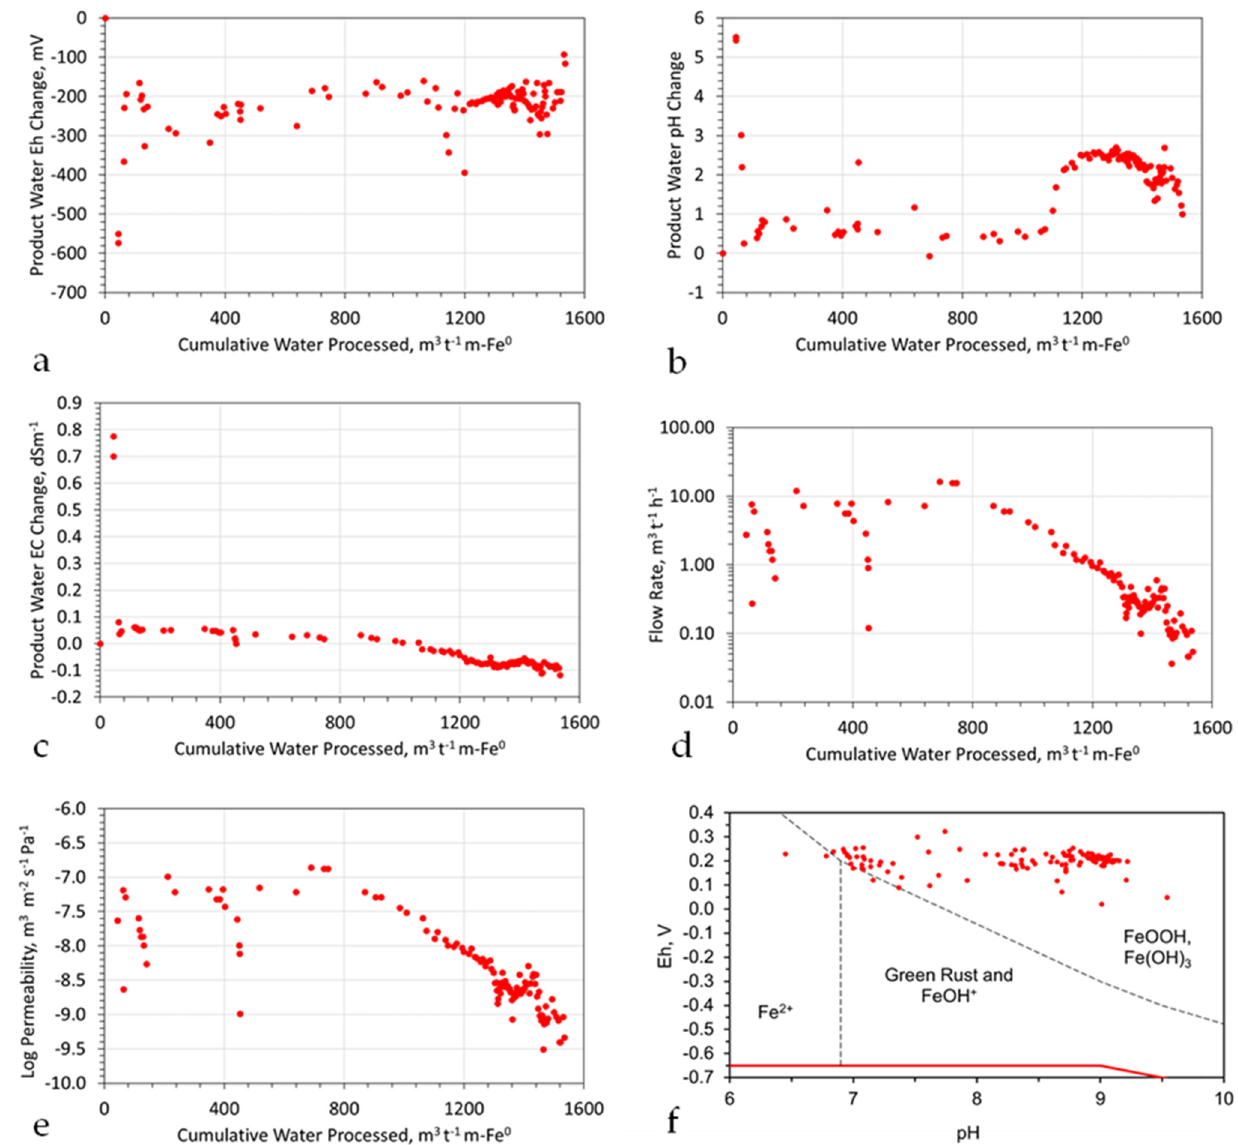
Figure A13. Example flow rate of water (Train A) through a fixed-bed reactor (0.5 m × 0.04 m O.D.) containing 0.5 kg of Fe 0 powder (2 to 80 micron particle size). Head = 1.3 m (13,000 Pa); a reactor containing 1 t of Fe 0 would have the dimensions (0.5 m high × 1.8 m O.D.). The feed water parameters were as follows: pH = 6.52; Eh = 0.415 volts; and EC = 0.306 dSm − 1 . The reactor was operated for 1840 h. ( a ), Eh change; ( b ), pH change; ( c ), EC change; ( d ); water flow rate, normalize to a commercial scale; ( e ), The permeability of the Fe 0 bed; ( f ), Pourbaix diagram showing product water composition, Eh of the Fe 0 surface (red line), and principal Fe ions and precipitates.